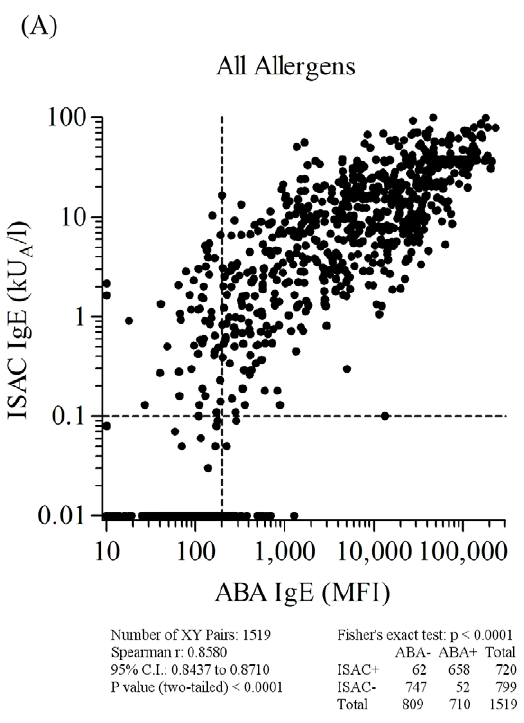
Figure 5. ABA versus ISAC IgE correlation results on 1,519 serum samples selected on the basis of any of the allergen specificities reported in Table S1, using the two micro systems. Letter flag (A) in figure 5 indicates it as part of the results shown also in figures 6, 7, and 8. Consecutive letters are used on purpose to recall result type continuity across the four figures. Allergen nature, being either natural or recombinant, matched for both tests. Vertical dashed lines represent the arbitrary ABA negative cut off value. Horizontal dashed lines mark the value range where ISAC IgE determinations are not always reproducible (unpublished data). For graphical visualization needs on log scales, zero values for ABA were set at 10 MFI on the X axis, and at 0.01 kU/l for ISAC values on the Y axis. The Spearman r correlation coefficient was calculated and the x 2 test was used for statistical purposes. Statistical results are reported below the